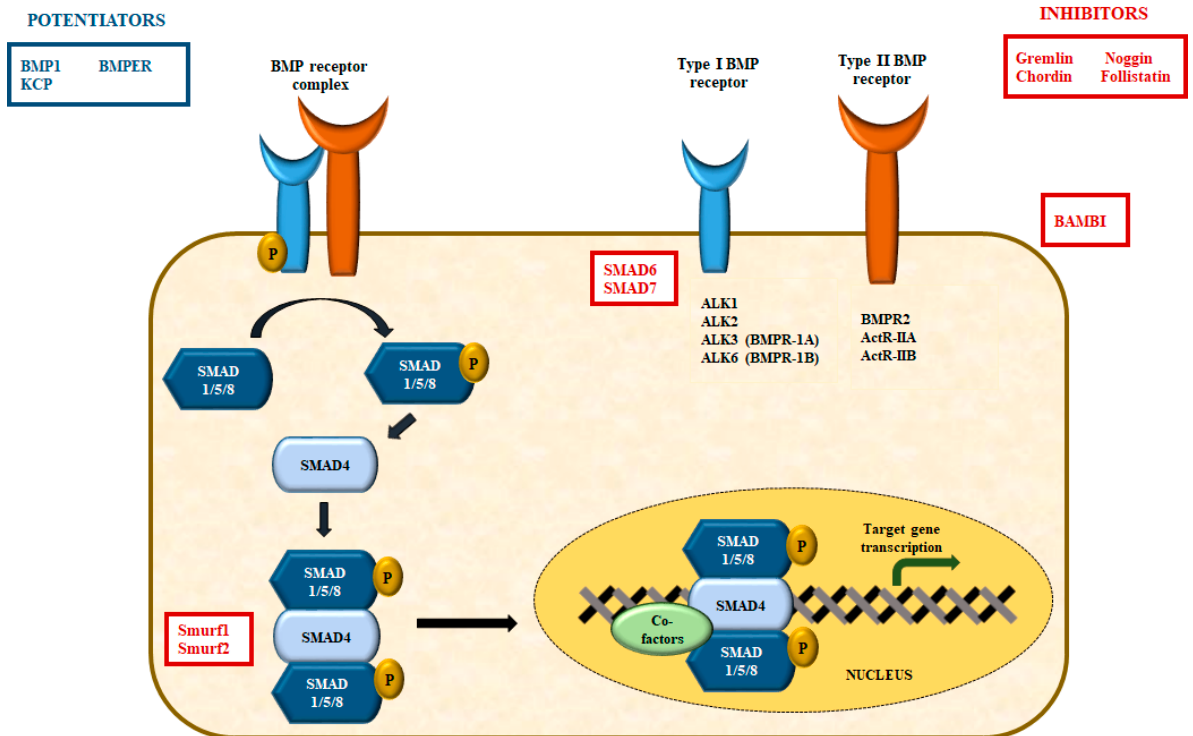
Figure 3. Summary of bone morphogenetic protein receptor signal transduction pathway. The catalysts or activators of BMP signaling are depicted in the blue box, while BMP signaling blocking agents or inhibitors are depicted in red boxes. BMP, bone morphogenetic protein; ALK, activin receptor-like kinase; BMPR; bone morphogenetic protein receptor; ActR, activin receptor; BMPER, BMP binding endothelial regulator; BAMBI, BMP and activin membrane bound inhibitor; KCP, kielin/chordin ‐ like protein.